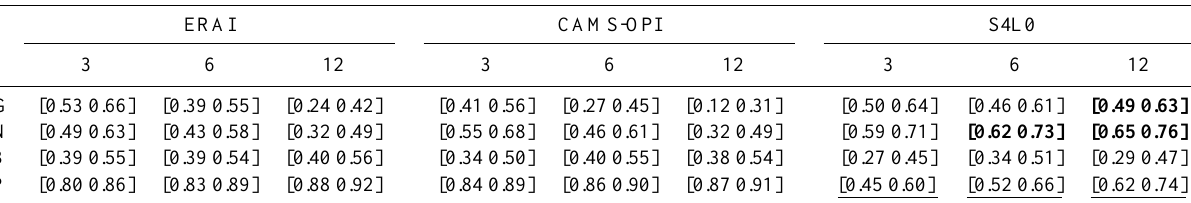
Table 2. Temporal correlation of the GPCP 3-, 6- and 12-month SPI and ERAI, CAMS-OPI and S4L0 (each column) for the different basins. The correlations are given by the lower and upper bounds for a 95% confidence interval. Bold (underlined) intervals indicate the dataset with higher (or lower) correlation and with confidence intervals outside of the range of the remaining datasets for each SPI timescale and basin.